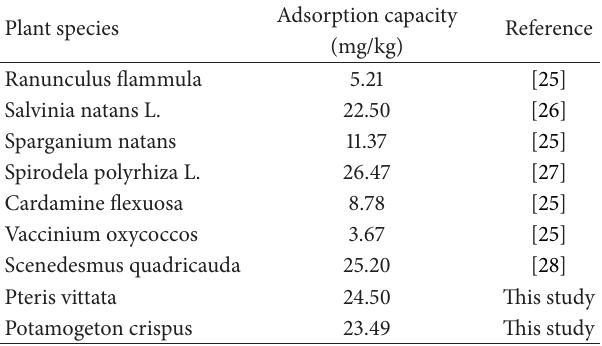
Table 3: Comparison of adsorption capacities of various plants for arsenic removal from aqueous